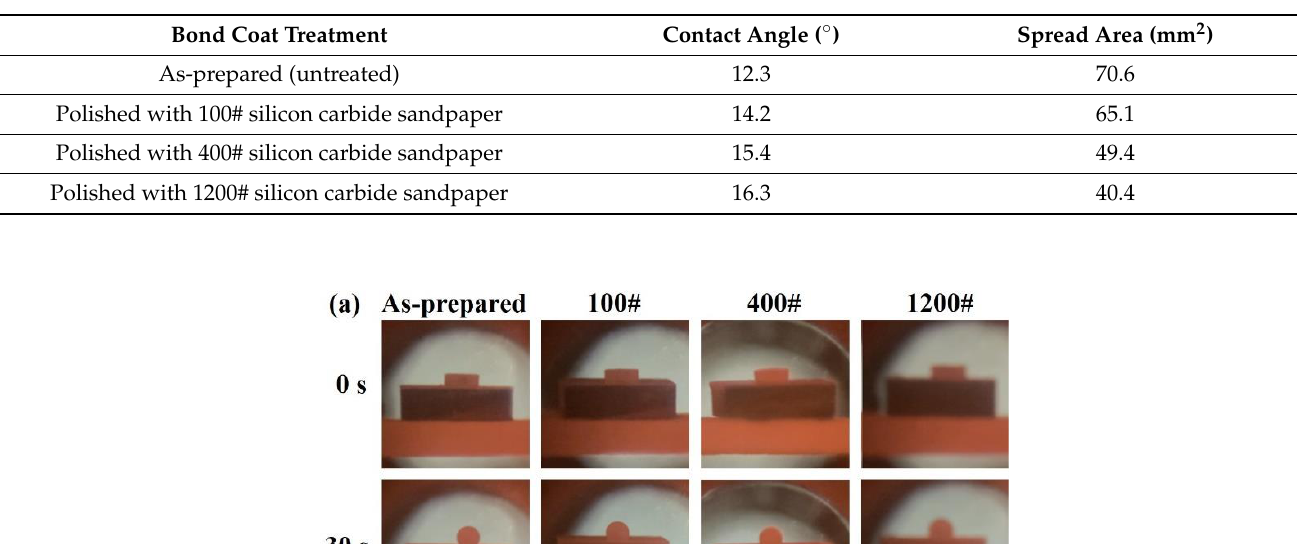
Table 4. Contact angle and spread area of CMAS on the surface of 7YSZ coatings with different roughness bond coats under CMAS wetting test.